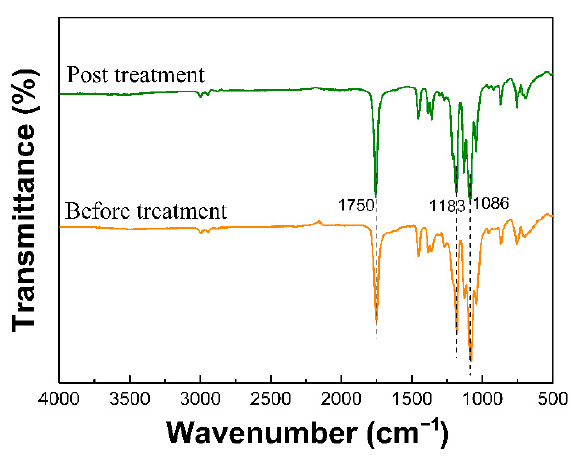
Figure 8. The ATR-FTIR spectra of samples before and after treatment with acetone.